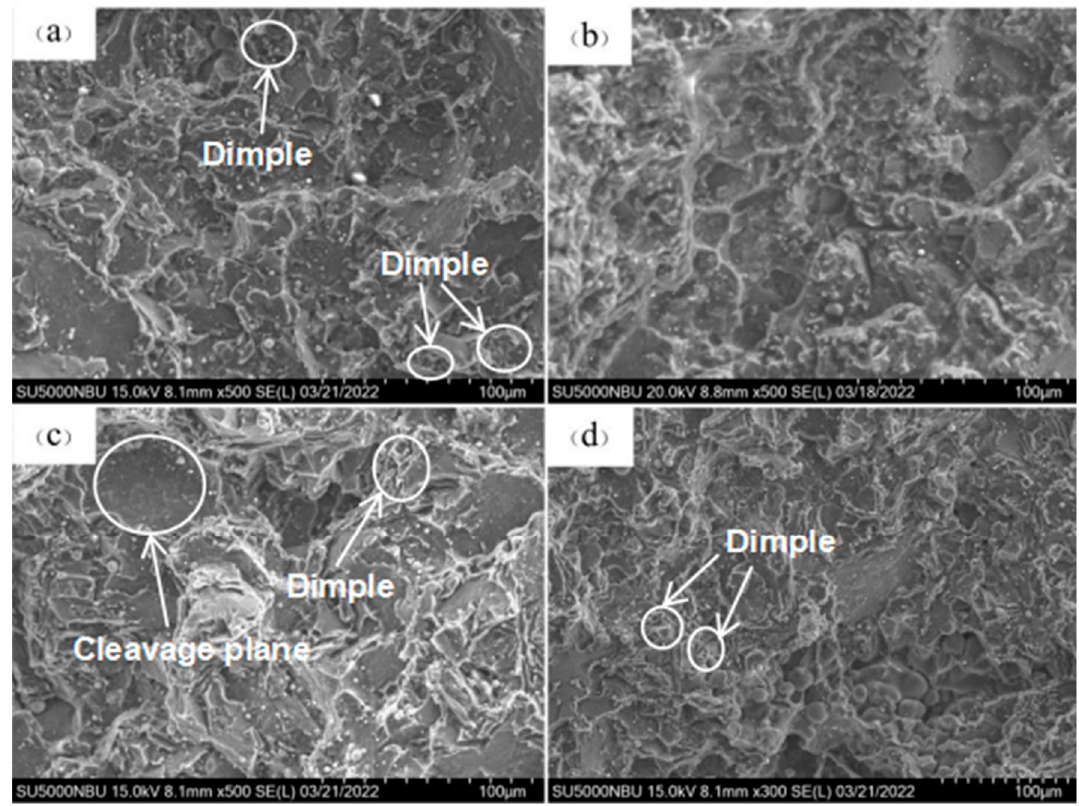
Figure 12. Fracture morphologies of different areas at boost pressures of 700 bar and 850 bar: ( a ) thin-walled area under 700 bar, ( b ) thin-walled area under 850 bar, ( c ) thick-walled area under 700 bar, ( d ) thick-walled area under 850 bar.